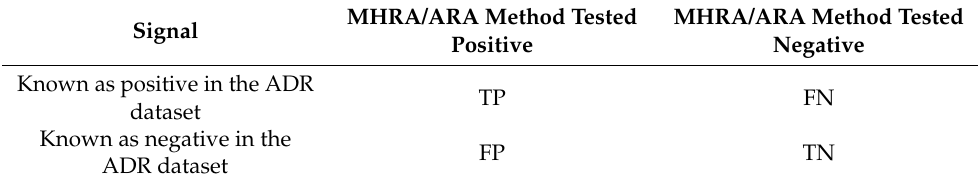
Table 2. Performance evaluation metrics of MHRA/ARA